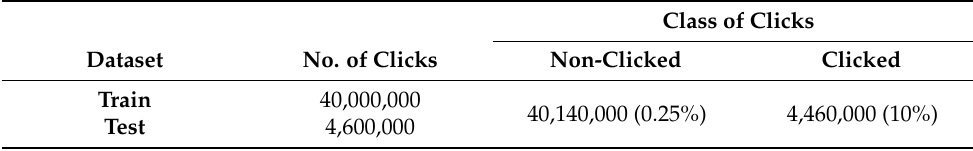
Table 6. Statistics of the Avazu click-through rate prediction